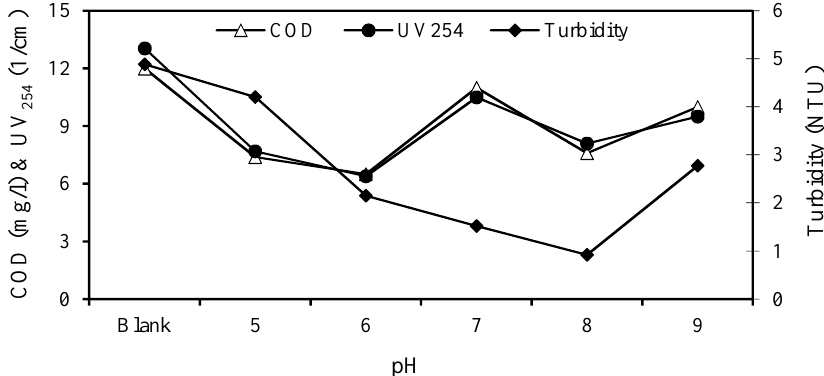
Fig. 2. Effect of pH variations on removal of COD, UV 254 , and turbidity in EC